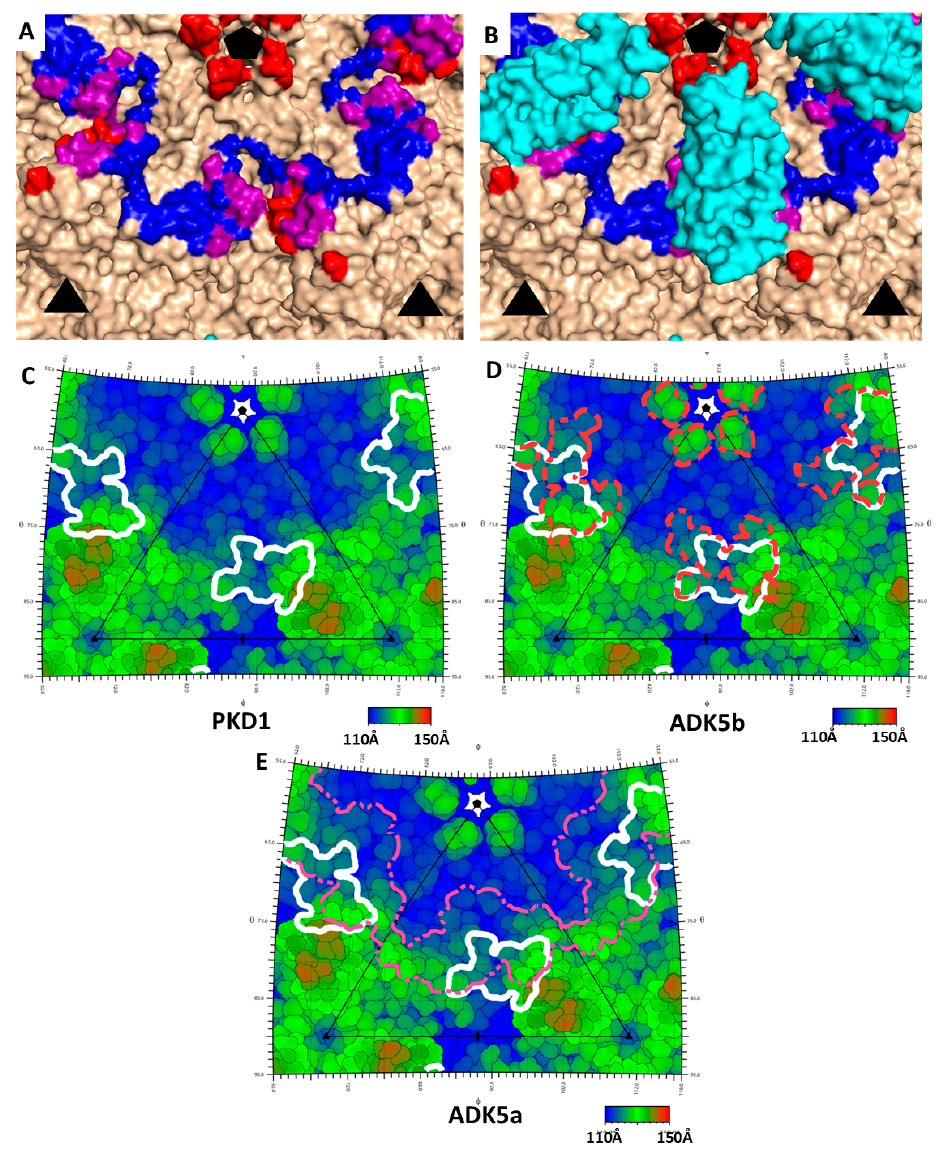
Figure 3. Overlap in the binding sites on AAV5 of receptor AAV5 and antibodies ADK5a & ADK5b. ( A ) The solvent accessible surface of AAV5 is colored with the ADK5a footprint blue, AKD5b red, and amino acids common to both, purple. The footprints comprise residues identified in prior EM structures at 11 Å resolution [35]. Three-fold symmetry axes, marked as triangles, map to equatorial three-folds left and right of center in Figure 1B, while the five-fold (pentagon) maps to a five-fold above center on the mid-line of Figure 1B. The view in in Figure 1B and here is down a two-fold axis. ( B ) The current structure of AAVR’s PKD1 is overlaid (with its symmetry equivalents), showing that the antibody footprints are substantially occluded. ( C – E ) Roadmap projections of the AAV5 surface colored by distance from the center of the virus. The perspective is the same as in panels A & B. The triangle shows one unique asymmetric unit of the surface, which, if expanded 60-fold by the icosahedral symmetry, would generate the entire virus surface. ( C ) The contact footprint of AAVR PKD1 is outlined in white. It is concentrated on the side of a three-fold spike, and although the domain occludes access to a swath leading up towards the five-fold, there is not the previously reported [16] contact near the five-fold pore. A magnified version is provided in the supplement (Figure S5) with residues labeled. ( D,E ) illustrate the footprints of ADK5b and ADK5a superimposed on that of AAVR PKD1, showing substantial